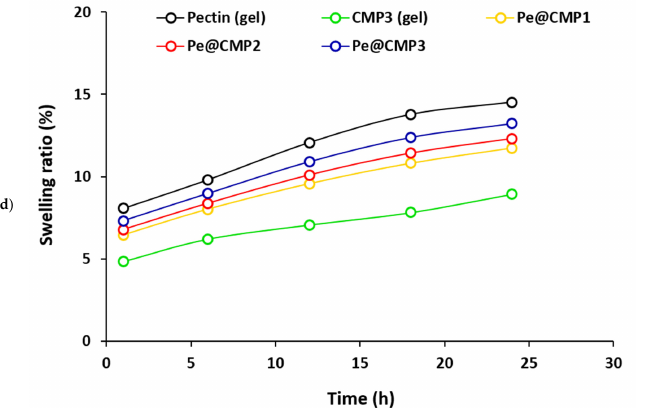
Figure 5. Solution uptake and swelling ratio for the pectin, CMP and Pe@CMP hydrogel; ( a ) water uptake, ( b ) artificial sweat uptake, ( c ) swelling in water and ( d ) swelling in artificial sweat. The swelling properties of the Pe@CMP composite hydrogels were then studied at different time up to 24 h in water, NaCl and artificial sweat medium as represented in Figure 5c,d and supplementary file. The swelling ratio was gradually increased by the immersed time and the difference in the swelling ratio was not significant by